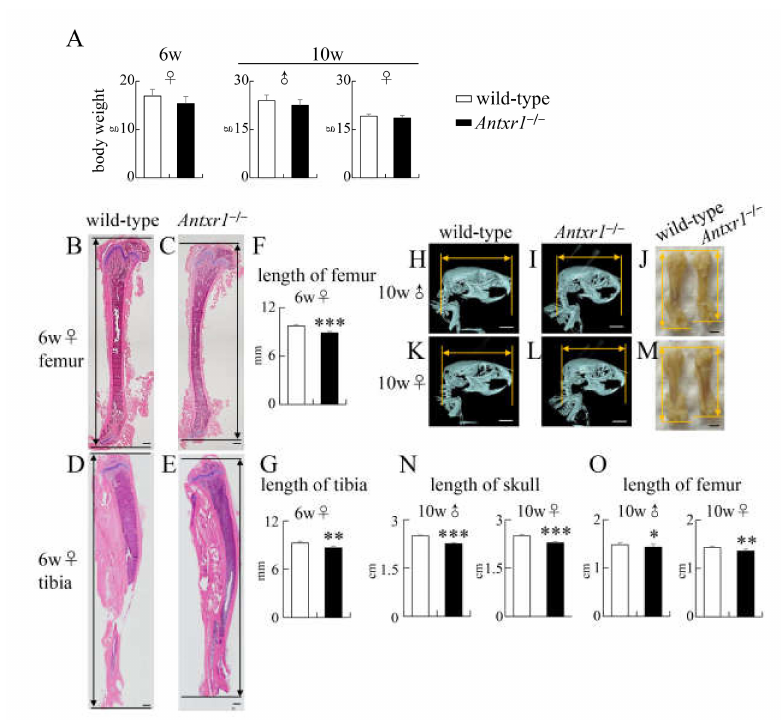
Figure 5. Body weight and histological and micro-CT analyses of wild-type and Antxr1 – / – mice at 6 weeks and 10 weeks of age: ( A ) Body weights of female mice at 6 weeks of age and of male and female mice at 10 weeks of age. ( B – E ) H-E staining of femurs ( B , C ) and tibiae ( D , E ) in female wild-type ( B , D ) and Antxr1 – / – ( C , E ) mice at 6 weeks of age. ( F , G ) The lengths of femurs and tibiae at 6 weeks of age were measured using histological sections, as shown in B – E . ( H , I , K , L ) Lateral view of micro-CT images of skulls of male ( H ) and female ( K ) wild-type mice and of male ( I ) and female ( L ) Antxr1 – / – mice at 10 weeks of age. ( J , M ) The appearance of femurs in male wild-type and Antxr1 – / – mice ( J ) and of female wild-type and Antxr1 – / – mice (M) at 10 weeks of age. ( N ) The skull length at 10 weeks of age was measured using micro-CT images, as shown in H , I , K , and L . ( O ) The length of femurs at 10 weeks of age was measured, as shown in J and M . Scale bars: 500 µ m ( B – E ), 0.5 cm ( H , I , K , L ), and 0.2 cm ( J , M ). The number of mice analyzed: body weight at 6 weeks of age, wild-type: 5, Antxr1 – / – : 5; the length of femurs at 6 weeks of age, wild-type: 4, Antxr1 – / – : 5; body weights and the lengths of skulls and femurs in male mice at 10 weeks of age, wild-type: 12, Antxr1 – / – : 7; body weights and the lengths of skulls and femurs in female mice at 10 weeks of age, wild-type: 7, Antxr1 – / – : 9. Versus wild-type mice, * p < 0.05, ** p < 0.01, *** p <